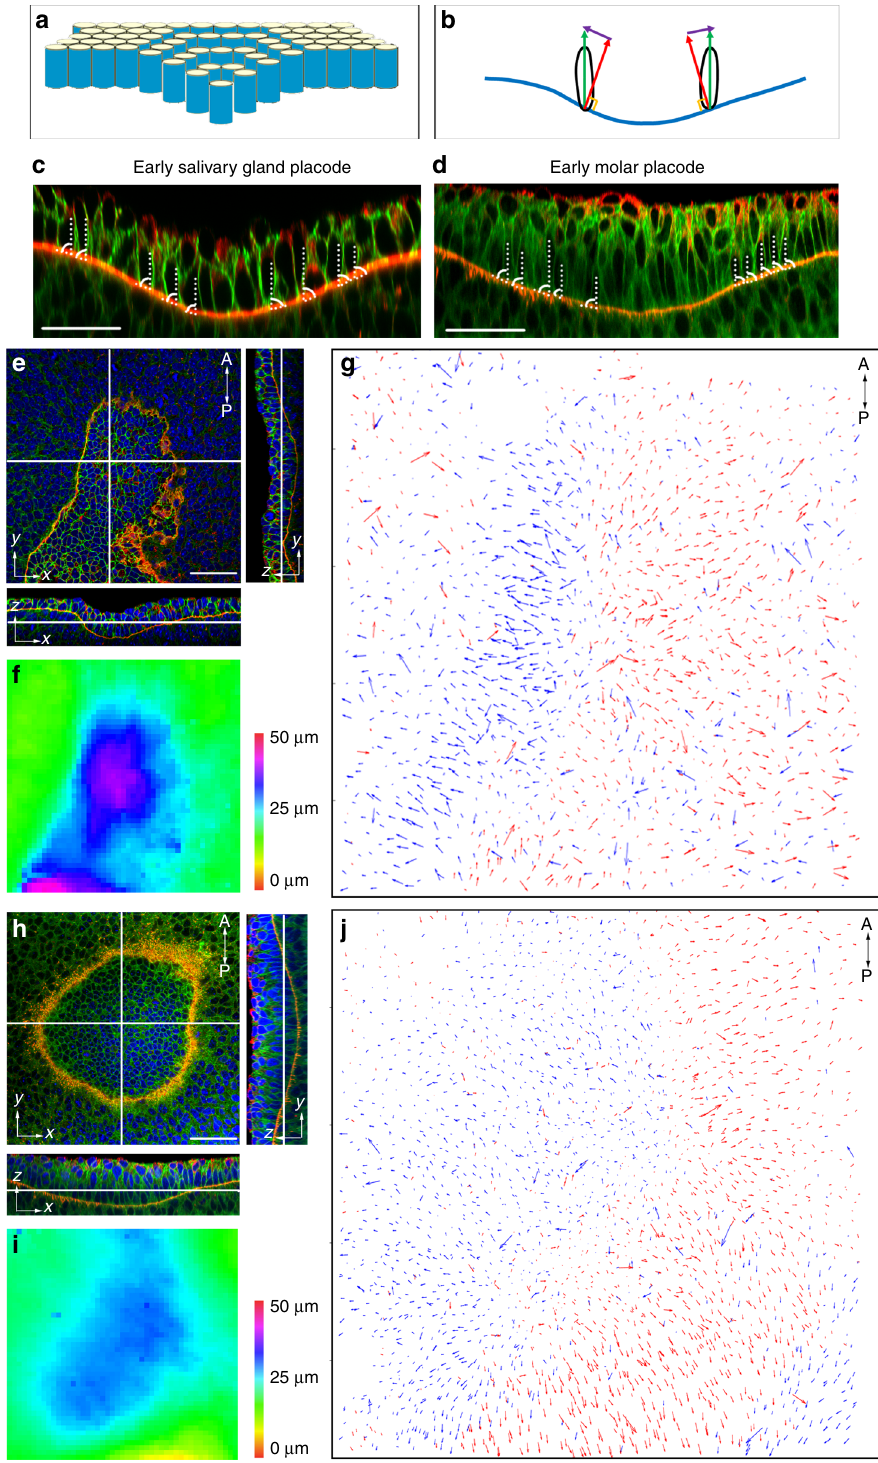
Fig. 2 Vertical telescoping in early SG and molar invagination. a Schematic showing vertical sliding between cells to generate invagination. b Schematic illustrating the method of measuring and displaying cell tilt. Green vector: major axis of a basal cell. Red vector: normal vector of the local lamina. Purple vector: the displacement between the green and red vectors. Blue line: basal lamina of the placode. c , d Immuno fl uorescence of transverse sections of SG and molar placode. Green: β -catenin. Red: Laminin- α 1. Dashed lines: major axes of cells. Curved lines: the angle between the local lamina and the major axes of cells. e , h Immuno fl uorescence of SG placode ( e ) and molar placode ( h ), top ( xy plane) view and orthogonal ( yz and zx plane) views. Green: β -catenin. Red: Laminin α 1. Blue: DAPI. f , i Heat map of the depth of the SG ( f ) and molar placode ( i ). g , j Vector map of the displacement angle between cell and lamina vectors of the SG placode in ( e ) and the molar placode in ( h ) indicating VT. Arrows are coloured by their direction to the left (blue) and right (red) to facilitate visualisation. Note that due to the asymmetry of the SG placode, arrows on the left side (buccal side) of the placode are longer than those on the right (lingual), corresponding to the steepness of the slope. Maps are representative of three independent litters, for placode type and of six and three different placodes for SG and molars respectively. Scale bars: 50 μ